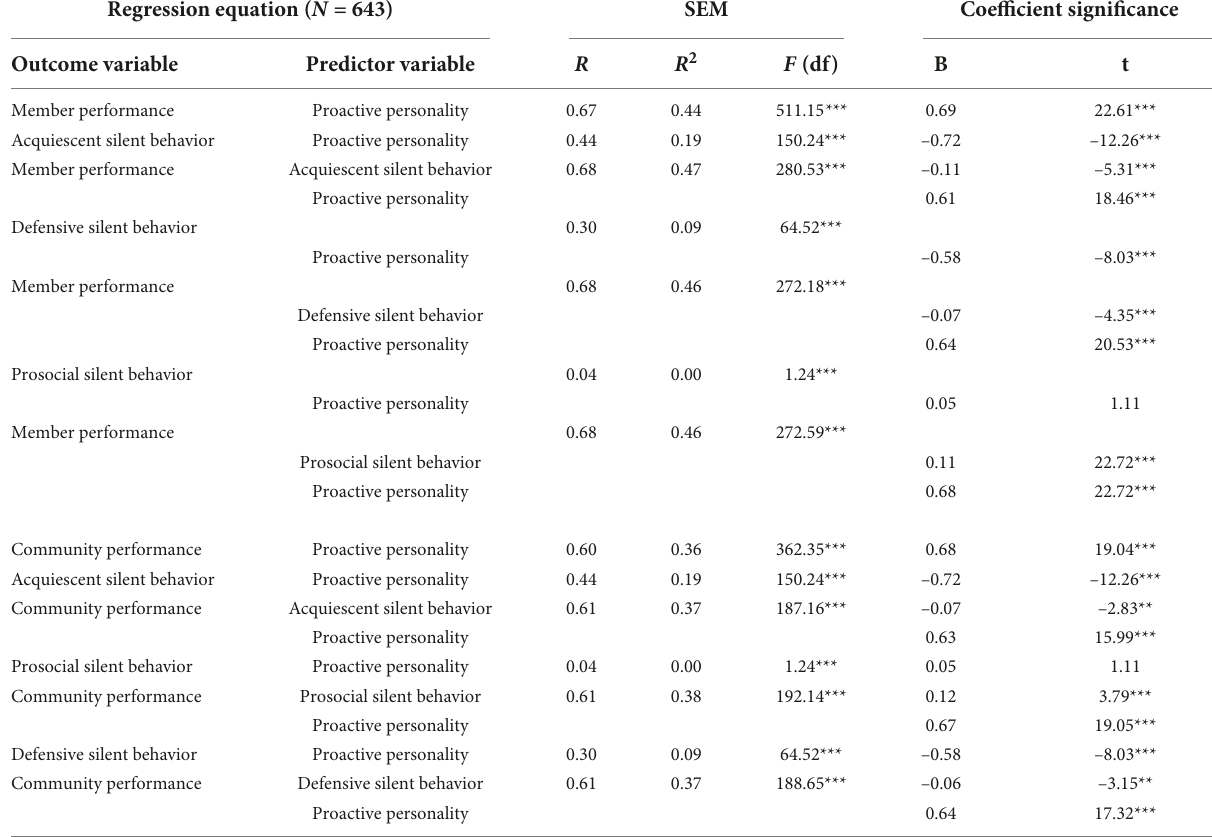
TABLE 5 Results of bootstrapping for the mediating